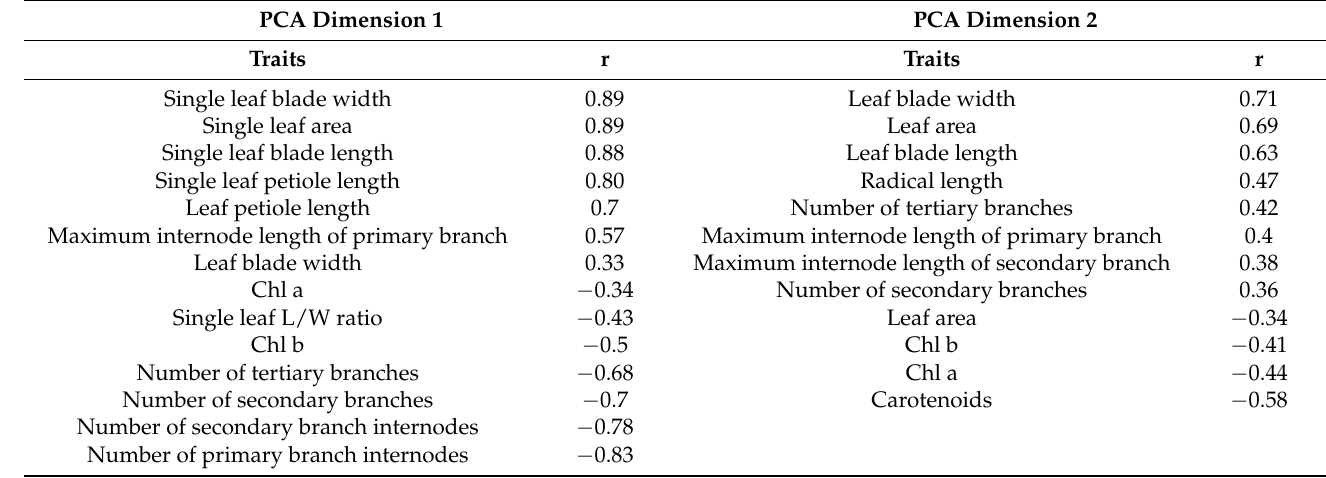
Table 1. Pearson correlation (r) for the significantly correlated variables (with p -value of <0.001) with the first two components of PCA. Variables are sorted in a descending order according to correlation value.